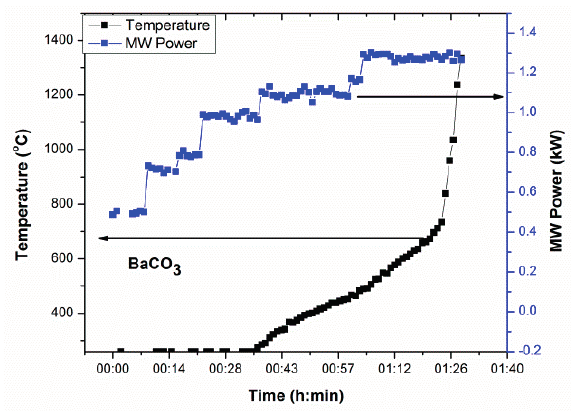
Figure 8. T-P-t profile of BaCO 3 under direct microwave radiation.